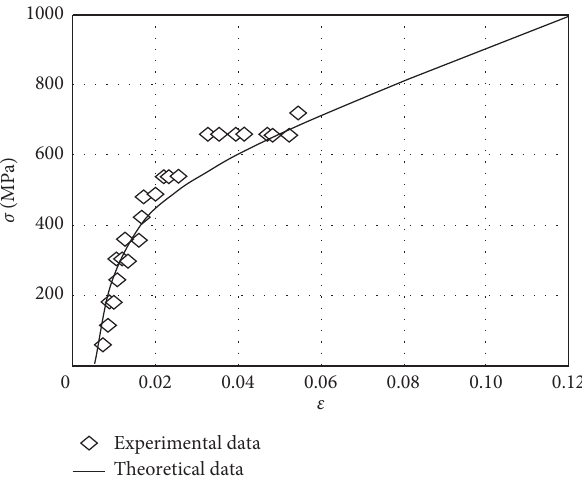
Figure 11: The dependence between the average value of micro- plastic deformation and the applied tensile stress in the deposited samples of steel 530H40 after thermal improvement in mode II (group II).